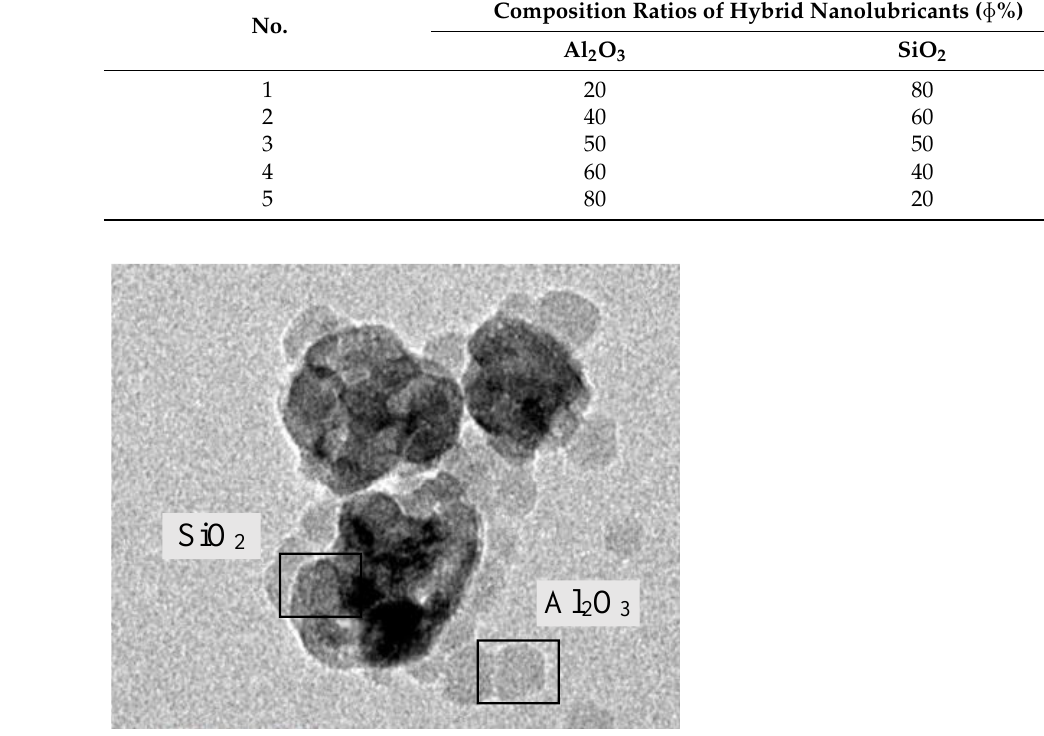
Figure 1. TEM image of the hybrid nanolubricants.